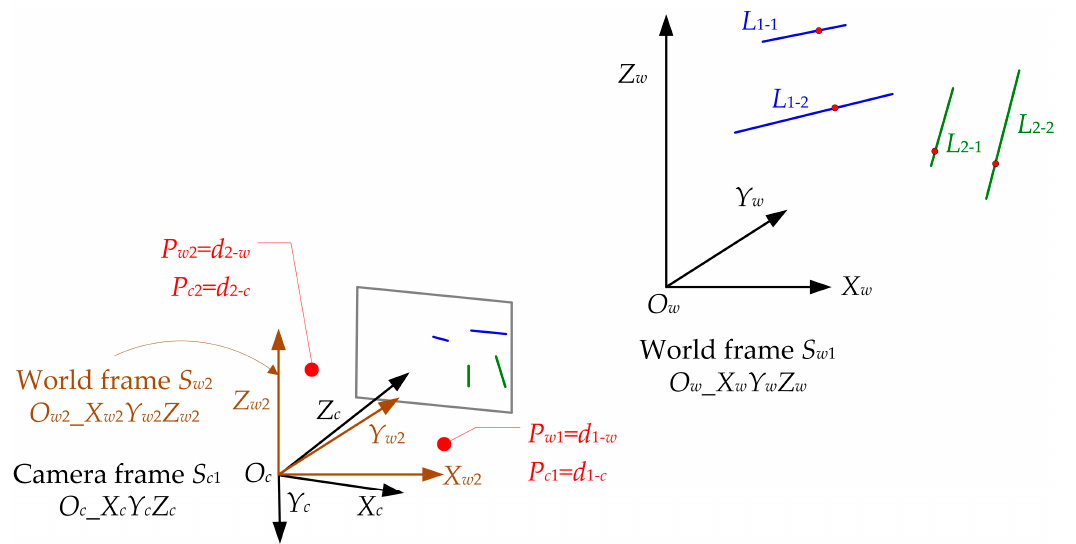
Figure 3. New world frame (brown) and two virtual 3D points (red).